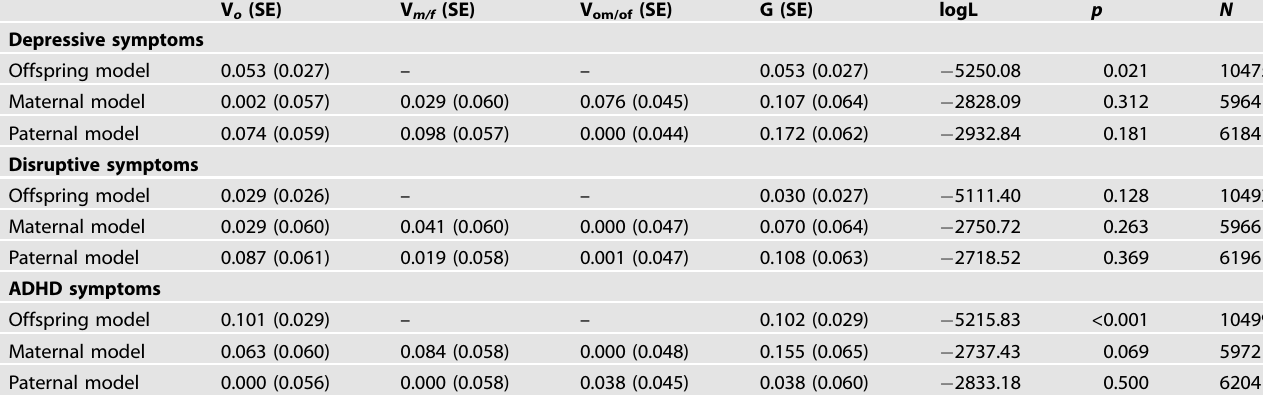
Table 1. Estimates of variance explained, standard errors, and sample sizes of the fi tted